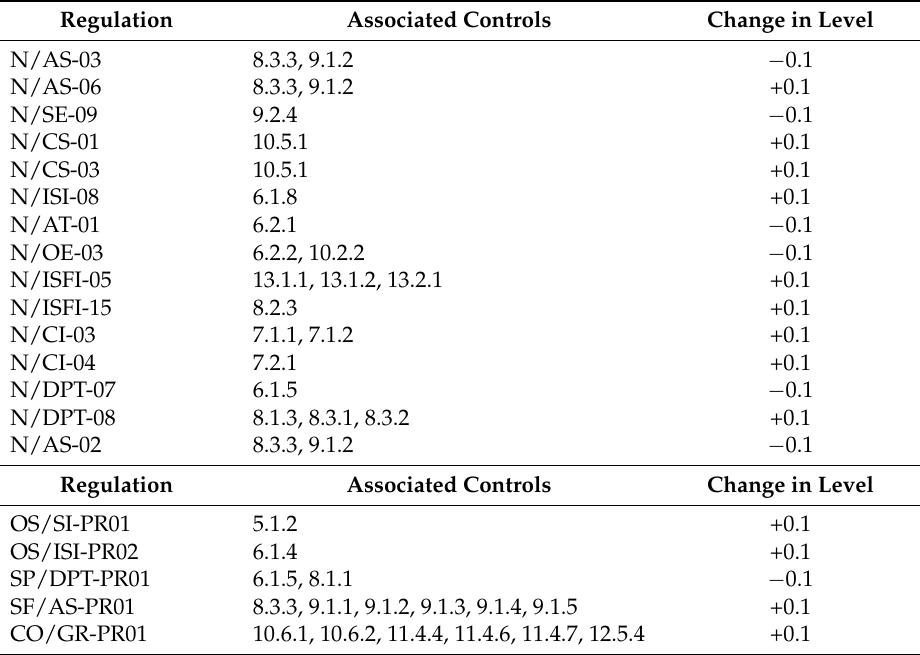
Table 4. Example of penalization of controls for security